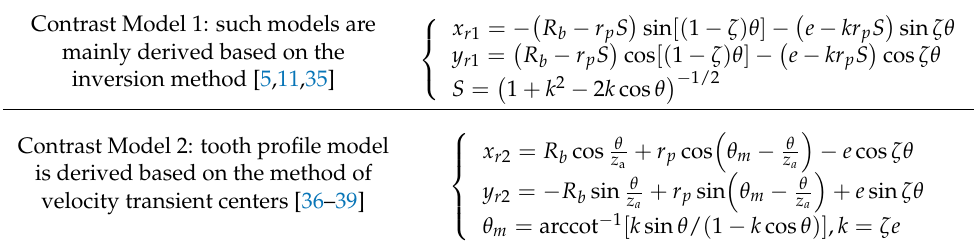
Table 1. Cycloid tooth profile model for